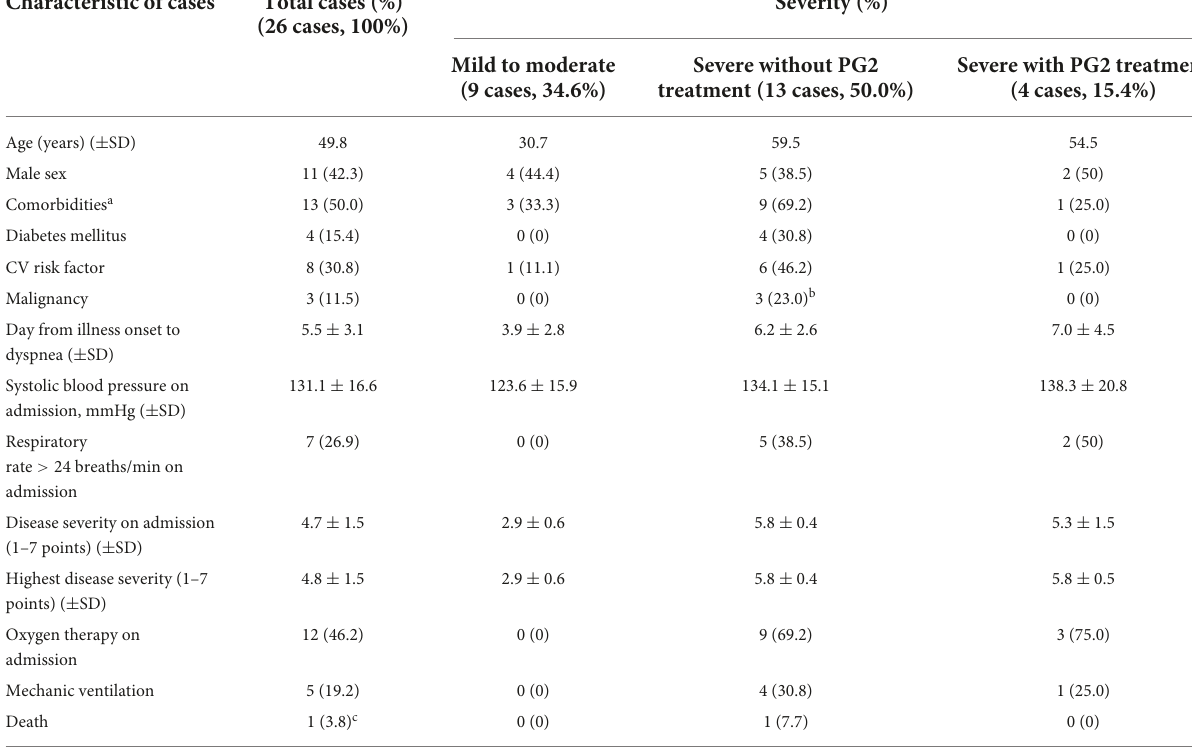
TABLE 1 Clinico-demographic data and outcome profiles of 26 patients with laboratory-confirmed COVID-19. Characteristic of cases Total cases (%) Severity (%) (26 cases, 100%) Mild to moderate Severe without PG2 (9 cases, 34.6%) treatment (13 cases, 50.0%)